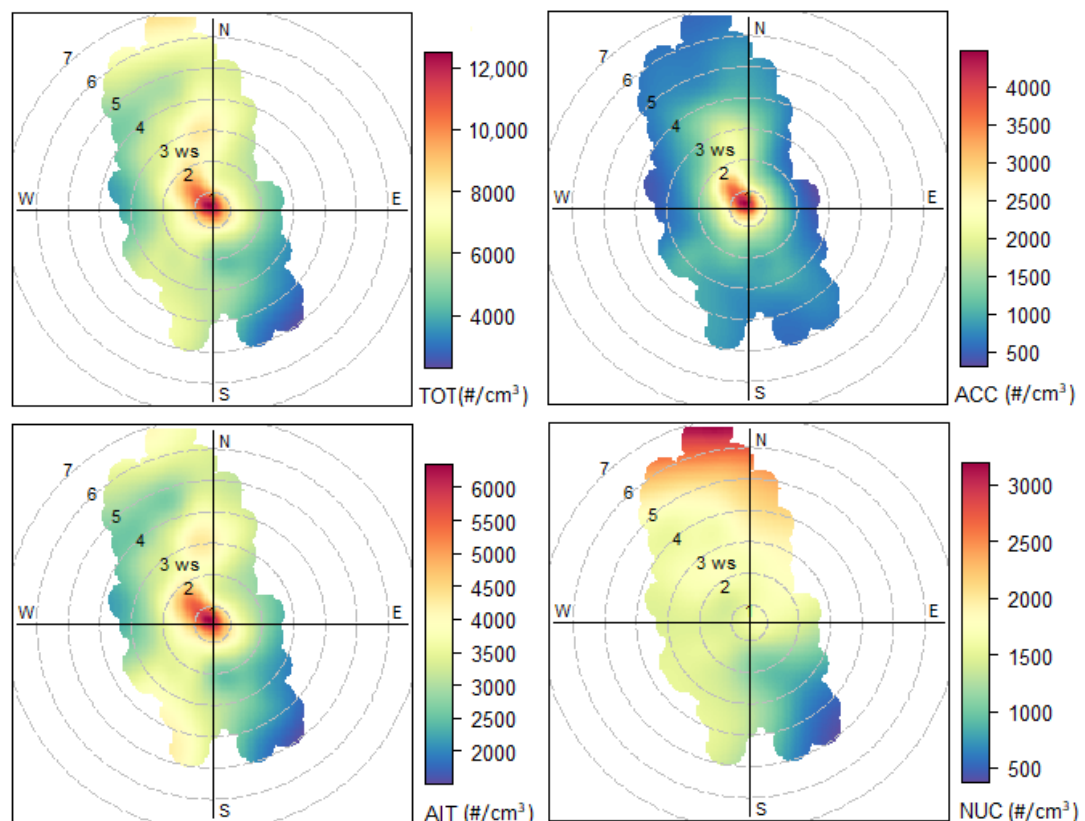
Figure 9. Pollution roses for each class of particle number concentrations, N TOT , N ACC , N AIT , and N NUC measured during the five-year period. Vertical color bars represent the number concentration.